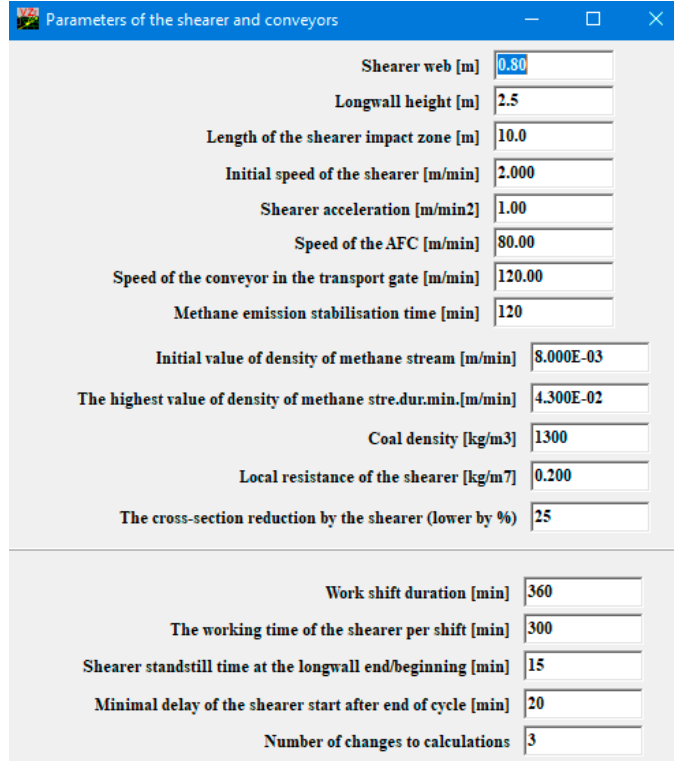
Figure 3. Adopted parameters of a model of methane emissions.